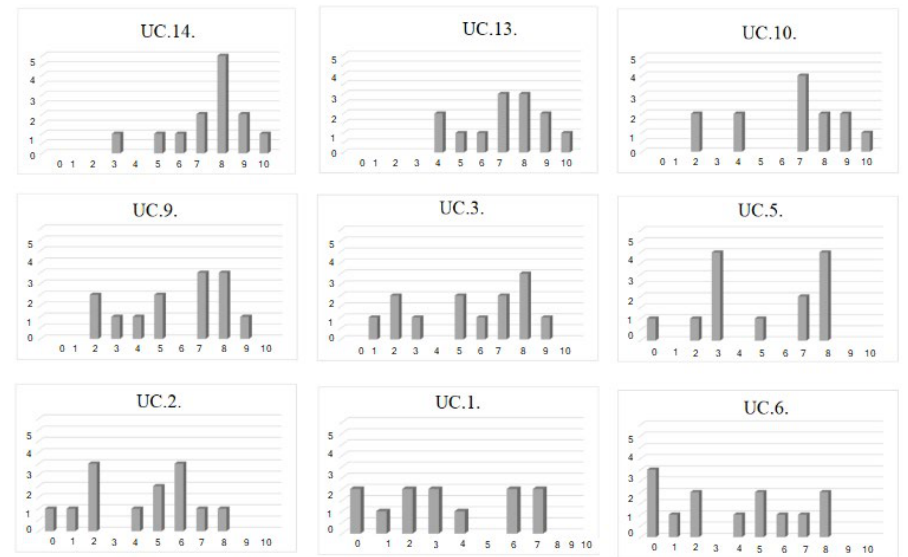
Fig. 3. Evaluation of the importance of user characteristics (UC)